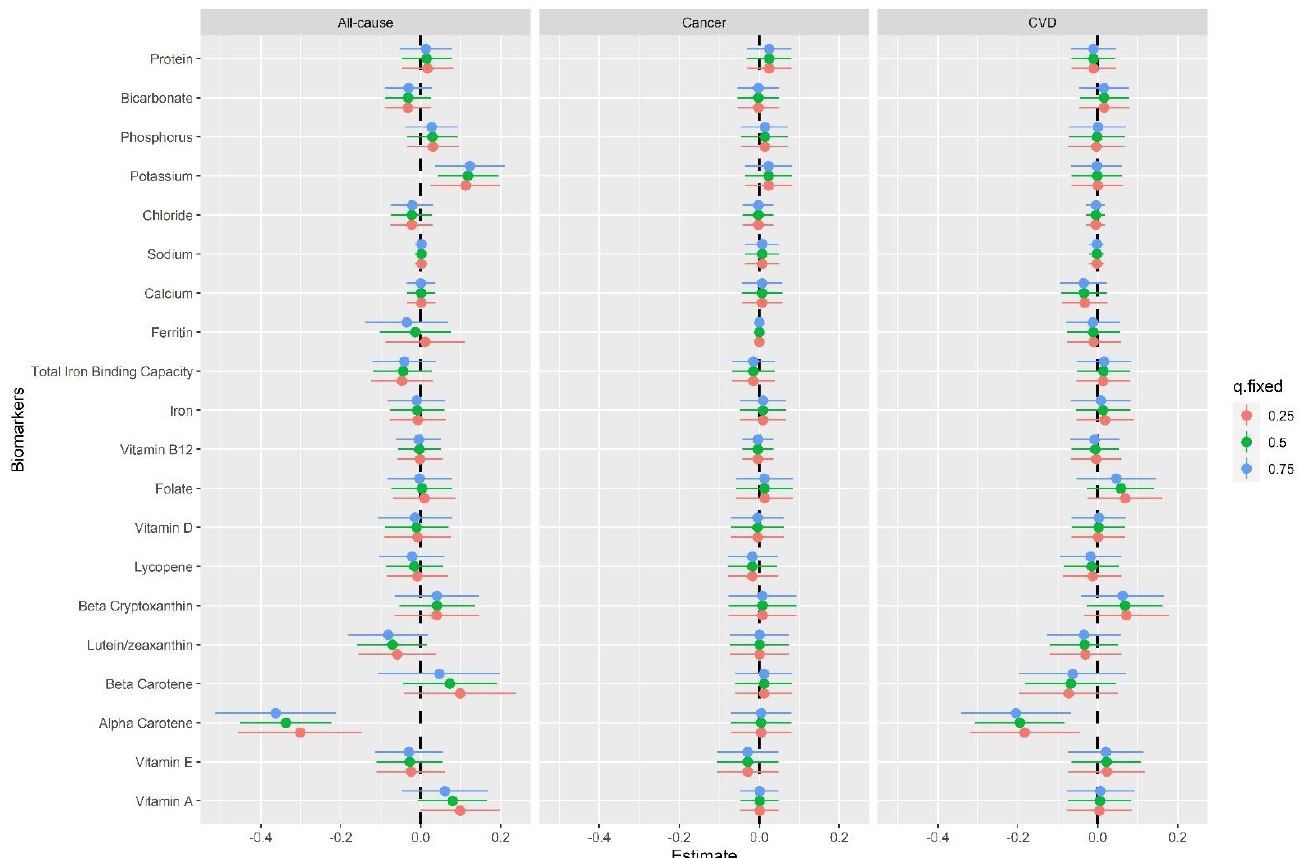
Figure 2. Single − biomarker health effects (95% CI), defined as the change in the response associated with a change in a particular biomarker from its 25th to its 75th percentile, where all of the other biomarkers are fixed at a specific quartile. Red, green, and blue represent the 25th percentile, 50th percentile, and 75th percentile, respectively.